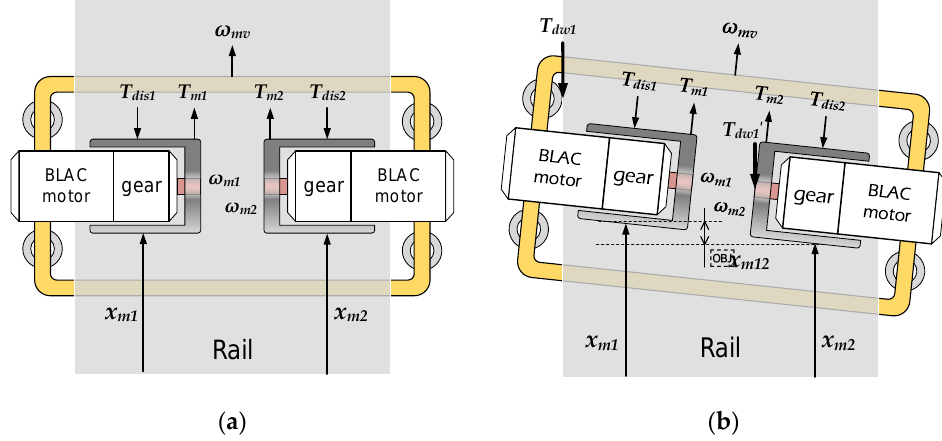
Figure 5. Moving characteristics in the overhang-type system: ( a ) ideal dual motor driving at the same speed; ( b ) actual moving from the velocity difference of two motors.